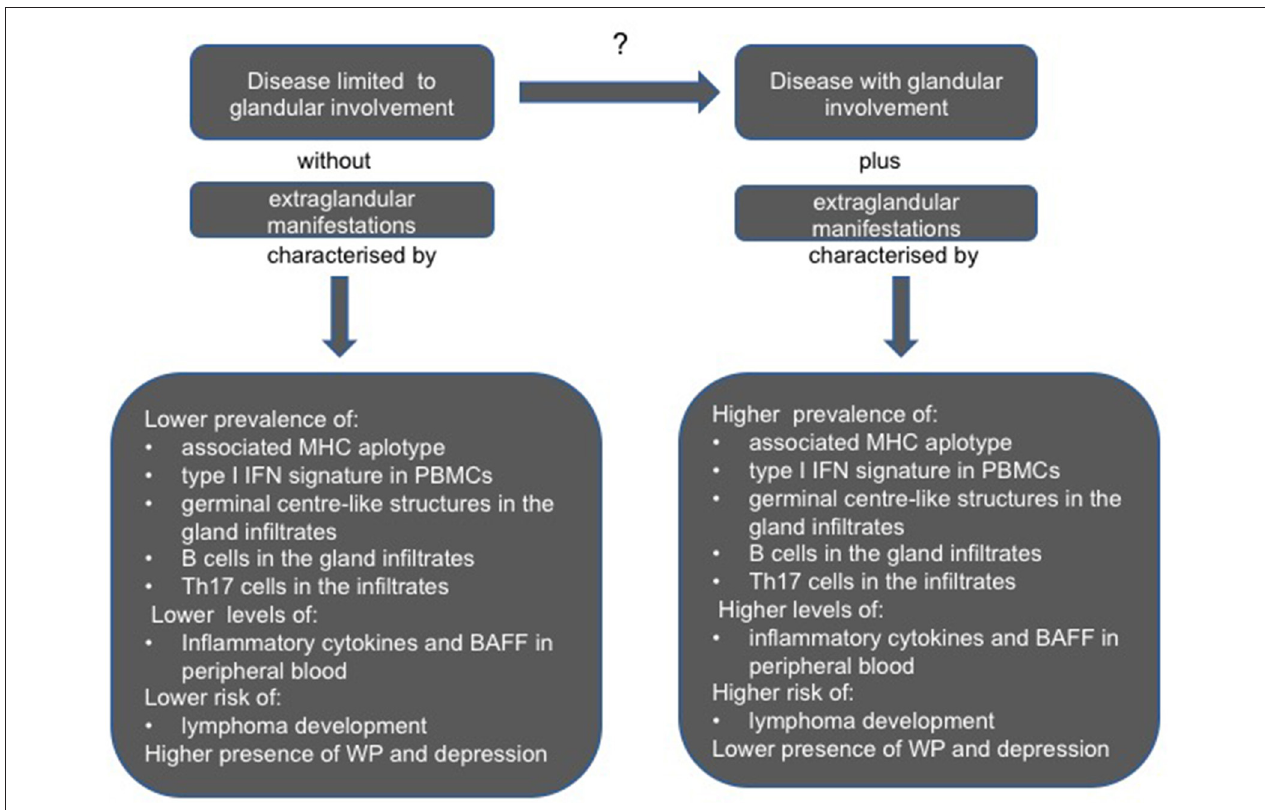
FIGURE 2 | Clinical, serological, and pathological differences between pSS patients with a disease limited to glandular involvement and absence of extraglandular involvement, and those with glandular features plus extraglandular manifestations. BAFF, B cell activating factor; IFN, interferon; MHC, major histocompatibility complex molecule; PBMCs, peripheral blood mononuclear cells; Th, T helper cell; WP, widespread